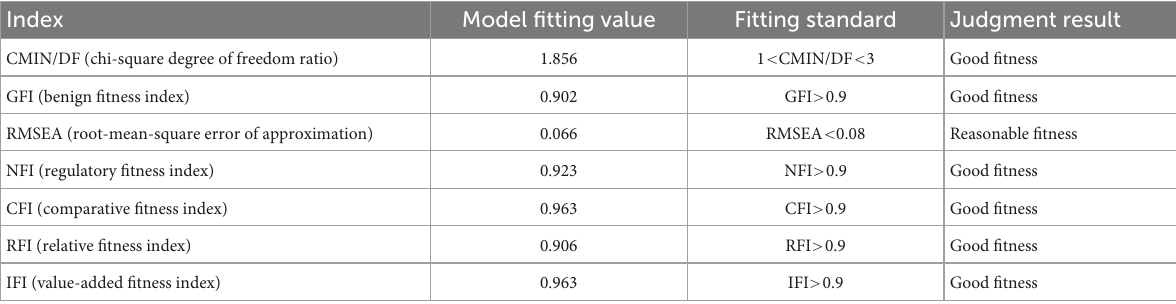
TABLE 7 Model fitting evaluation standard and evaluation